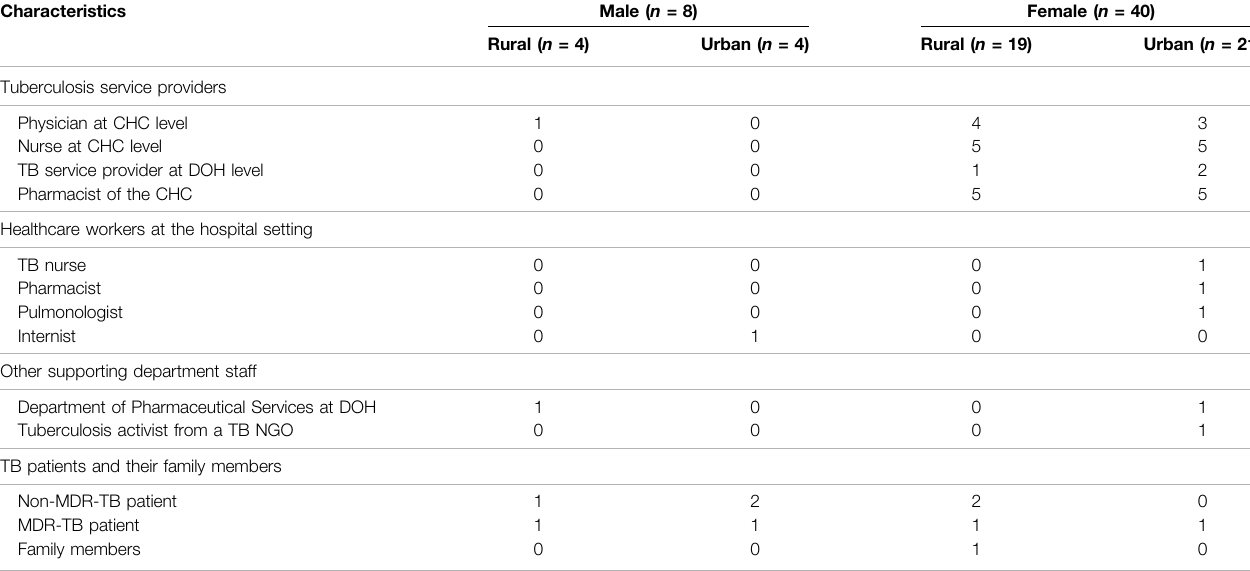
TABLE 1 | Characteristics of the participants ( n = 48).